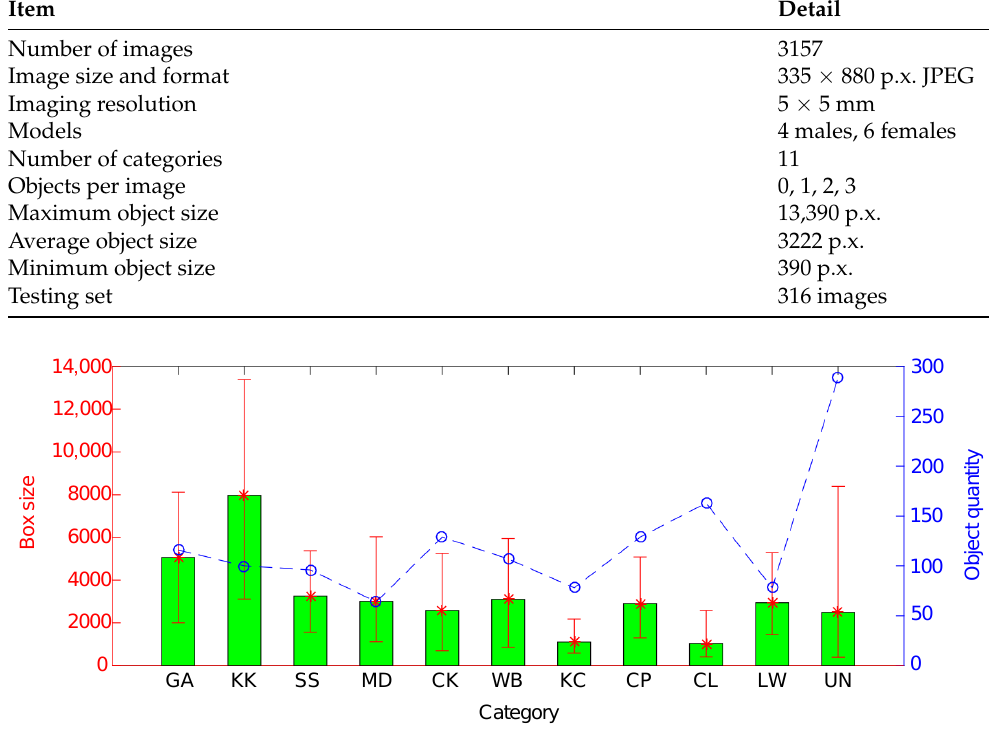
Figure 3. Average size of bounding box and quantity for each class in terahertz object detec- tion